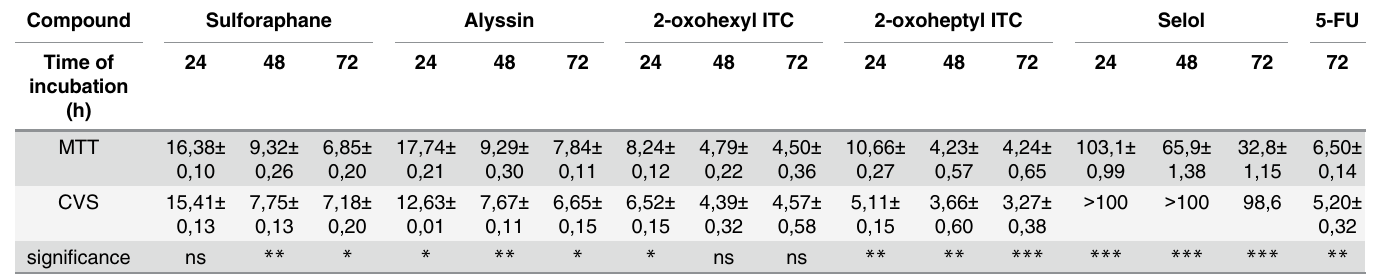
Table 1. IC 50 values ( μ M) of ITCs, Selol and 5-fluorouracil obtained by MTT and CVS assays.